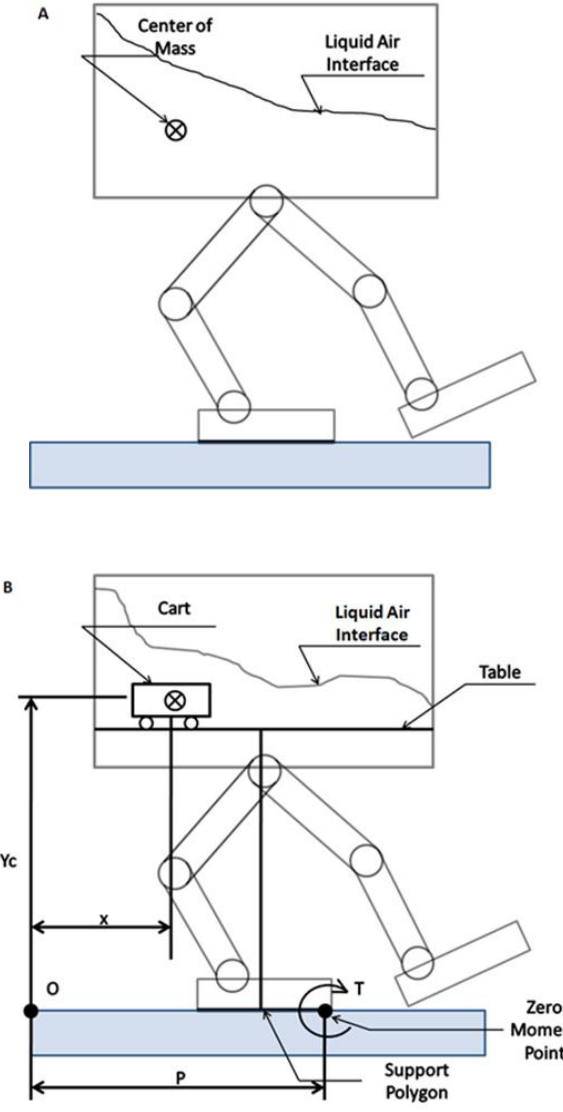
Figure 3. Liquid carrying robot: ( A ) simplified model, and ( B ) table cart description.